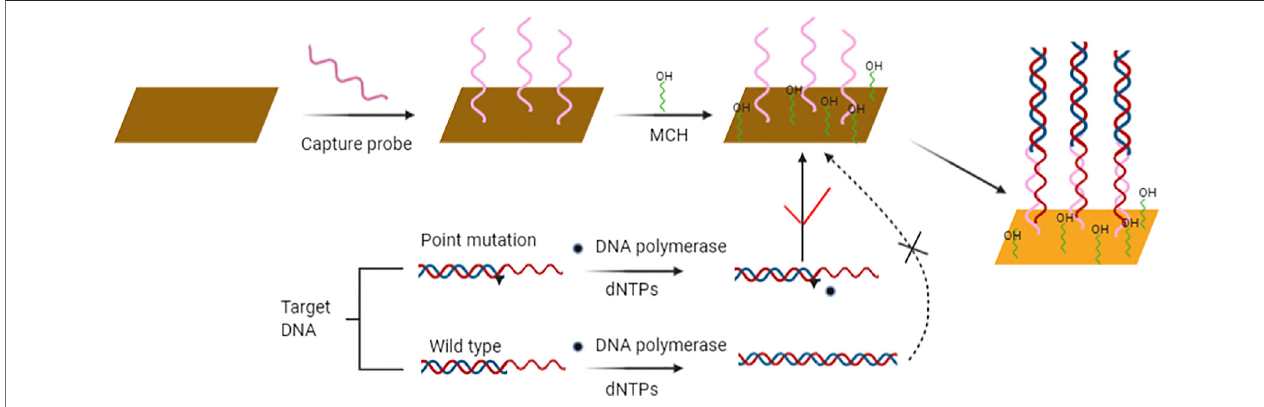
FIGURE3| Schematic diagram ofSPRbiosensor strategyfor rapidand sensitive point mutation detection. Contrary towildtype sequence,sequences containing point mutation are not elongated and consequently hybridize with the capture probe on the sensor ’ s surface and produce measurable signal output.